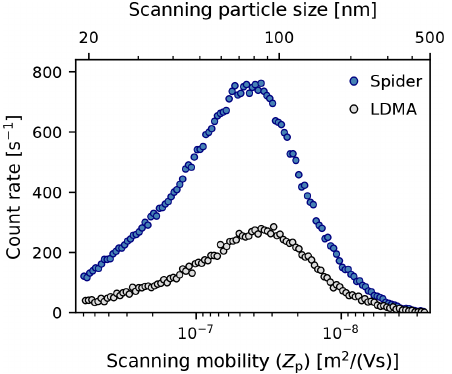
Figure 5. Sizing resolution effect on the particle count rate of the Spider DMA ( R = 3) and LDMA ( R = 10) systems. Data shown are the average of raw particle count rates during upscans over a period of 18min (corresponding to 3 LDMA upscans and 17 Spider upscans) measured in the morning of 1 June 2020. Both systems operated at 0.3Lmin − 1 aerosol flow rate.